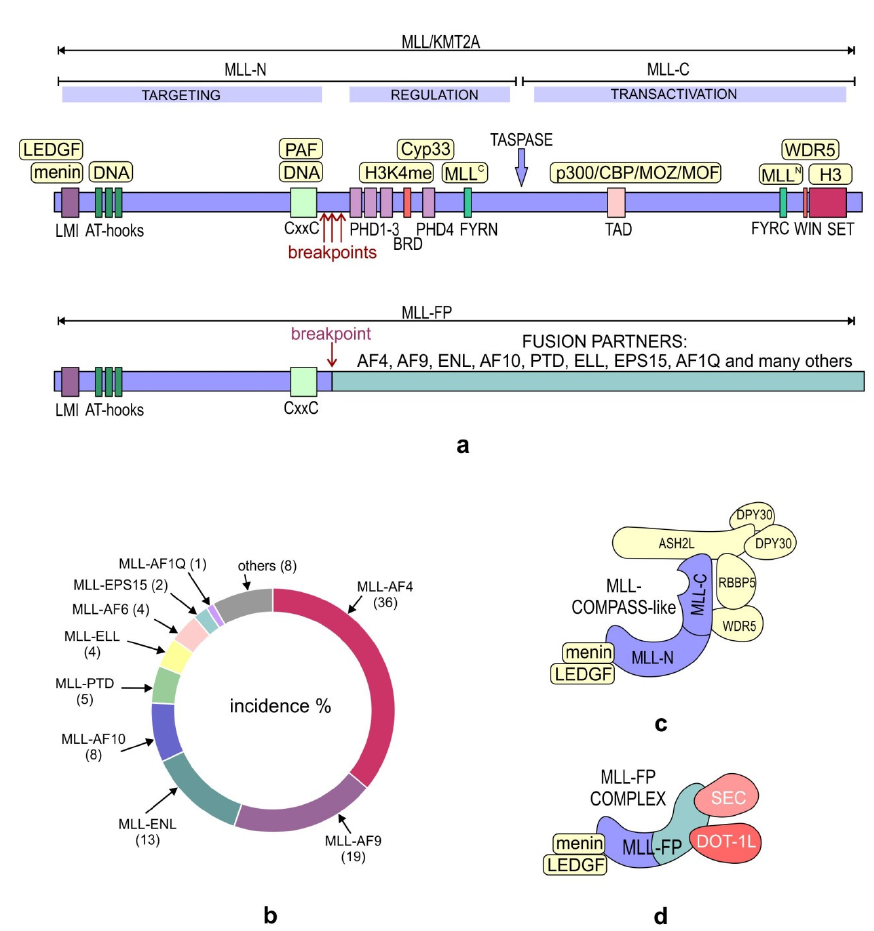
Figure 5. Wild-type KMT2A (MLL) and diverse KMT2A-fusion proteins (MLL-FPs). ( a ) Schematic representation of the wild-type (wt) KMT2A structure. Each domain is labeled in black capital letters, while interacting proteins are marked in rounded yellow-shaded rectangles. A cleavage site recognized by taspase 1 is annotated with a blue arrow. Three major functional parts of the protein responsible for targeting, regulation, and transactivation are also indicated. The protein product of the MLL/KMT2A gene is composed of 3969 amino acids and contains many domains that are involved in the regulation of gene transcription [122]. These include an AT-hook motif-binding DNA [123], a CXXC domain rich in cysteines [124,125], homeodomain (PHD) finger motifs [126], a bromodomain (BRD) [127], and a potent transcriptional activation domain (TAD) located between the amino acids 2829 and 2883 [128,129]. The KMT2A protein also contains a WIN motif responsible for the interaction with WDR5 and maintaining the H3K4me2 activity of the MLL core complex in vitro [130–132]. At the carboxy-terminal part of the protein, there is a SET domain conferring the histone methyltransferase activity of MLL [133,134]. A natural maturation course of MLL includes its proteolysis into two fragments, MLL-N and MLL-C, which then form a complex in vivo [135,136]. Two motifs—namely, FYRC and FYRN—are indispensable for heterodimerization between the terminal fragments of cleaved MLL, which can interact with many other proteins to form multiunit complexes required for transcriptional coactivator activity [134,137]. In MLL-FPs, many N-terminal domains, such as PHD, FYRN, FYRC, and SET, are lost. A detailed description is provided in the main text. ( b ) The most frequent rearrangements of KMT2A (MLL) in MLL. The data were obtained from Meyer et al. [99]. The three most frequent translocations of MLL are with AF4, AF9, and ENL. ( c ) Composition of the wt MLL COMPASS-like complex containing MLL-N and MLL-C. Core subunits (DPY30, ASH2L, WDR5, and RBBP5); Menin; and LEDGF are shown. ( d ) Composition of an MLL-FP complex. It contains MLL-FP, DOT1L, SEC, Menin, and LEDGF—the last two proteins are present in both wt and rearranged